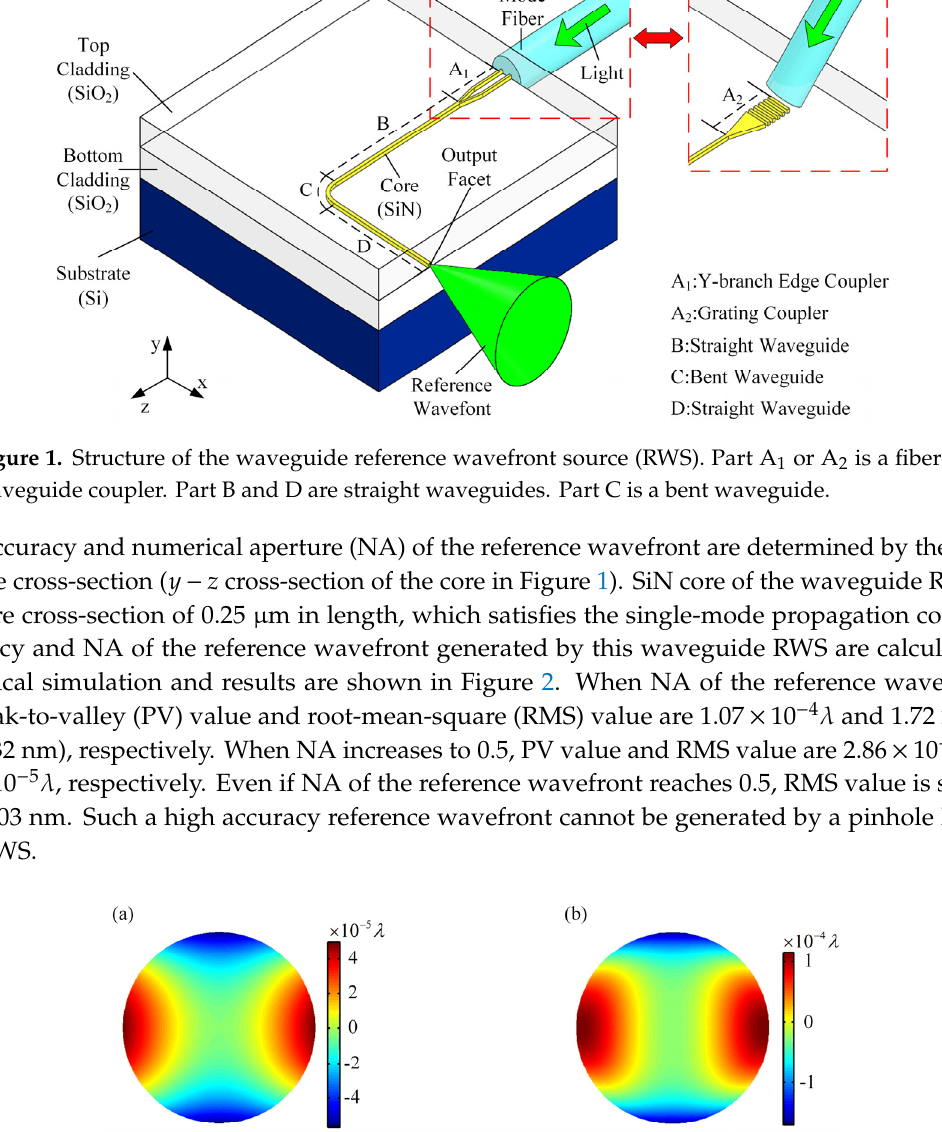
Figure 2. Accuracy of the reference wavefront generated by waveguide RWS when numerical aperture (NA) is ( a ) 0.3 or ( b ) 0.5.